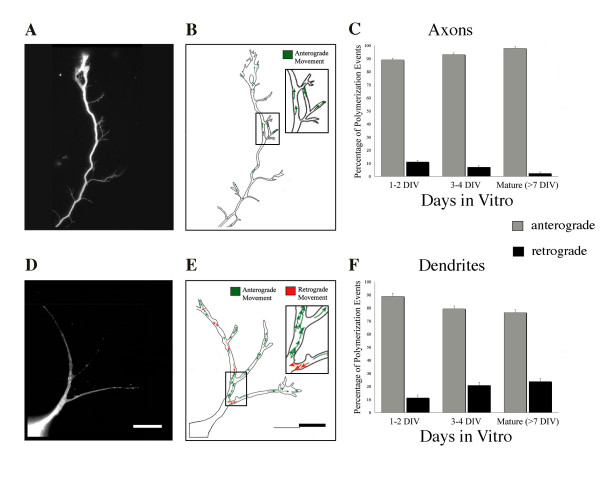
As neurons mature, the proportion of microtubules polymerizing in the anterograde direction increases to nearly 100% in axons, whereas the number of retrogradely oriented events observed in dendrites increases. (A, D) Single frames from the distal region of an axon (A) and a dendritic arbor (D) at 3 DIV, and (B, E) composite tracings of observed polymerization events, with individual EB1-GFP comet trajectories identified in the anterograde (green arrows) or retrograde (red arrows) directions. Insets depict enlarged views of the boxed regions. (C, F) The percentage of microtubule polymerization events occurring in an anterograde or retrograde direction was determined for each population of axons (C) and dendrites (F) observed throughout the developmental time-course. In axons, the total numbers of events tracked were: 833, 1 to 2 DIV; 892, 3–4 DIV; 284, 7+ DIV. For dendrites, the total numbers of events tracked were: 748, 1 to 2 DIV; 955, 3 to 4 DIV; 232, 7+ DIV. Scale bar, 10 μm. Error bars represent standard error of the mean. See Additional files 7 (axon) and 8 (dendritic arbor) for accompanying movies.